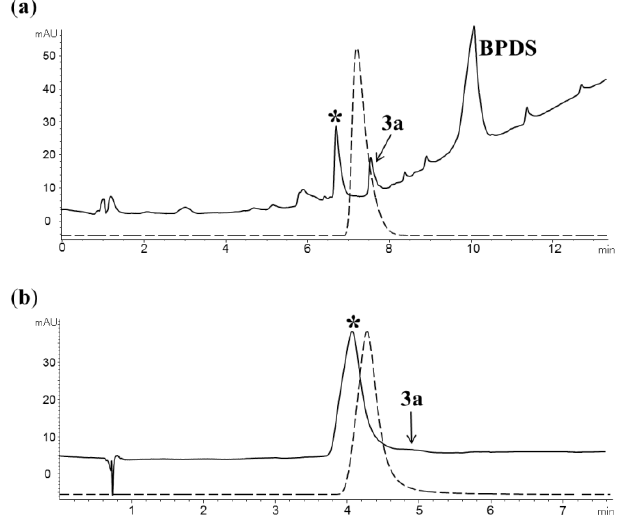
Figure 4. Analytical radio-HPLC profile (dotted line) and UV profile (265 nm, solid line) of [ 18 F] 7 obtained from the automated one-pot synthesis after using ( a ) Sep-Pak® Plus (Luna C18(2) column) and ( b ) and C-18 Sep-Pak® Light cartridge (Chromolith® performance column, RP18-e). Unidentified side product is labeled with